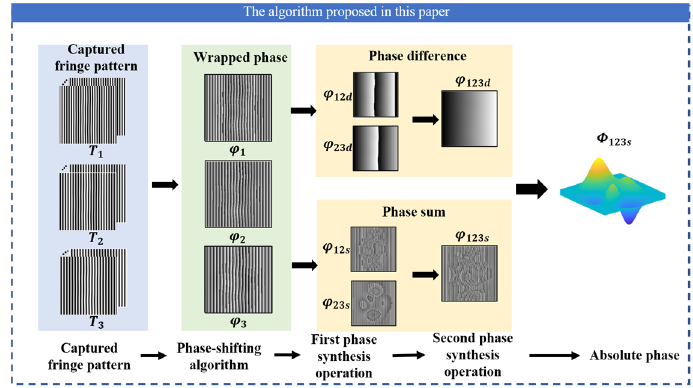
Figure 2. Schematic diagram of the proposed algorithm.